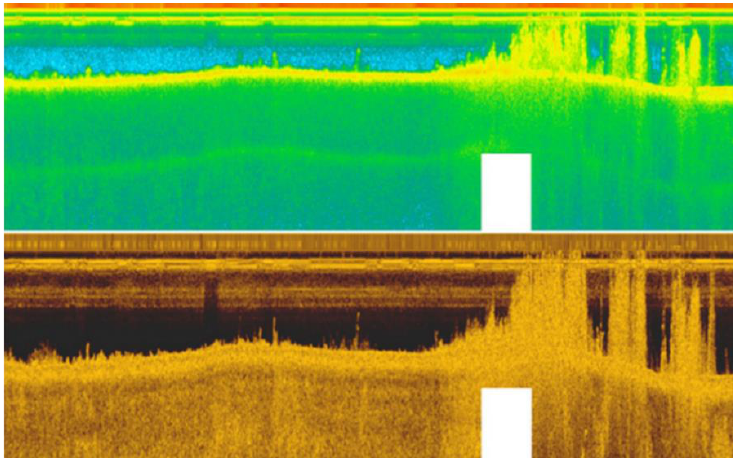
Figure 7. Output from a single beam echosounder at 200 kHz ( upper panel ) and 800 kHz ( lower panel ) wave frequency. Macrophyte presence is identified by the areas of signal reflections (in the upper right hand of each panel) above the lake bottom. From Stocks et al., 2019 used according to CC-BY-ND http://creativecommons.org/licenses/by-nd/4.0/. Accessed 07-10-2020 [33] .